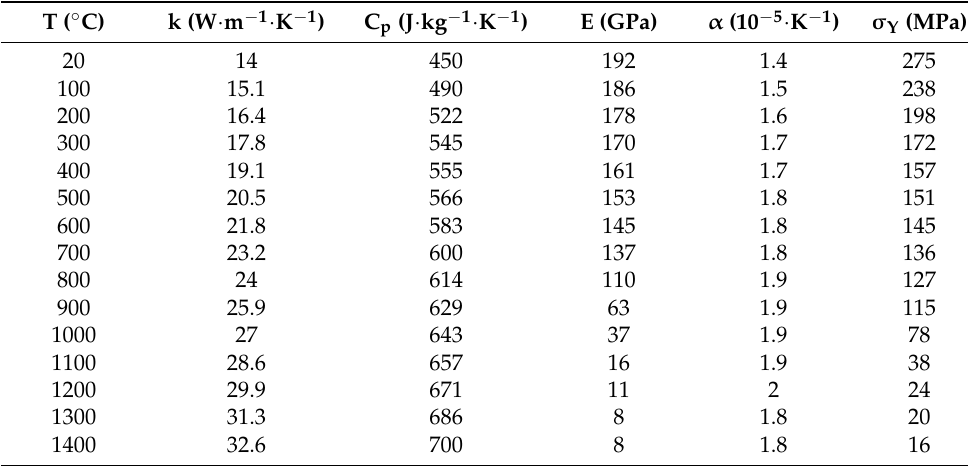
Table 1. Temperature-dependent material properties of stainless steel 316L